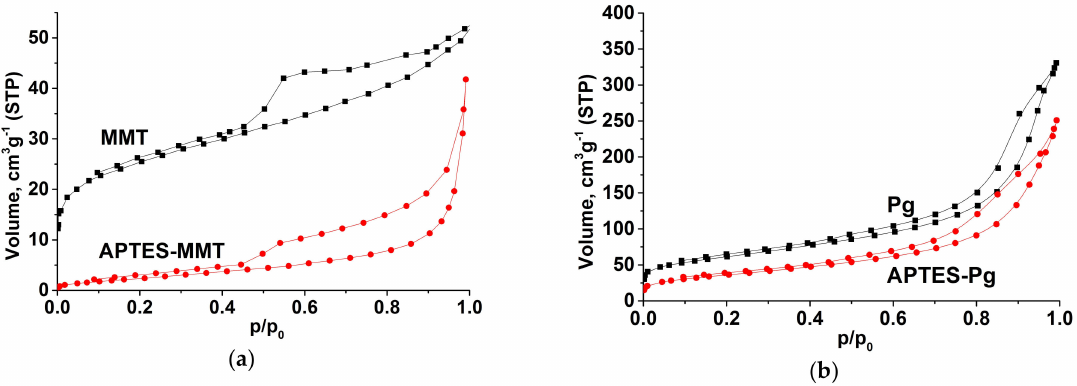
Figure 4. Nitrogen adsorption-desorption isotherms of pristine and APTES-modified clay minerals: ( a ) montmorillonite, ( b )